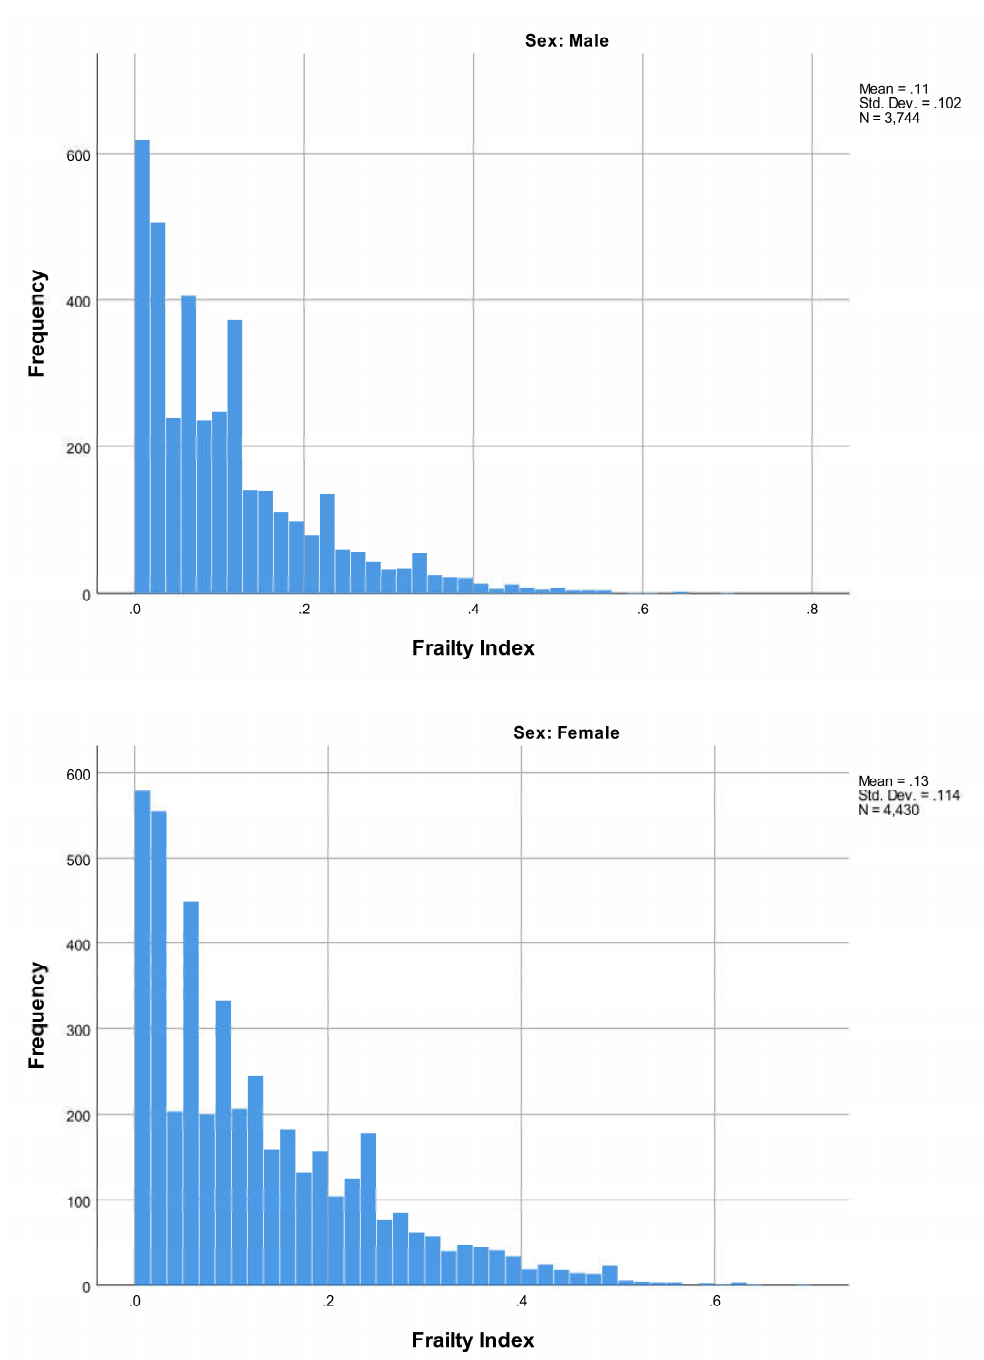
Figure A1. Distribution of the FI in men and women (total sample).